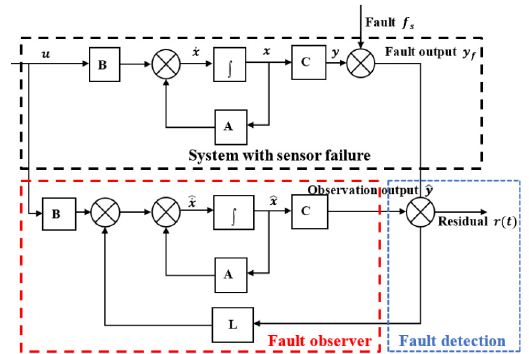
Figure 5 Structure diagram of fault